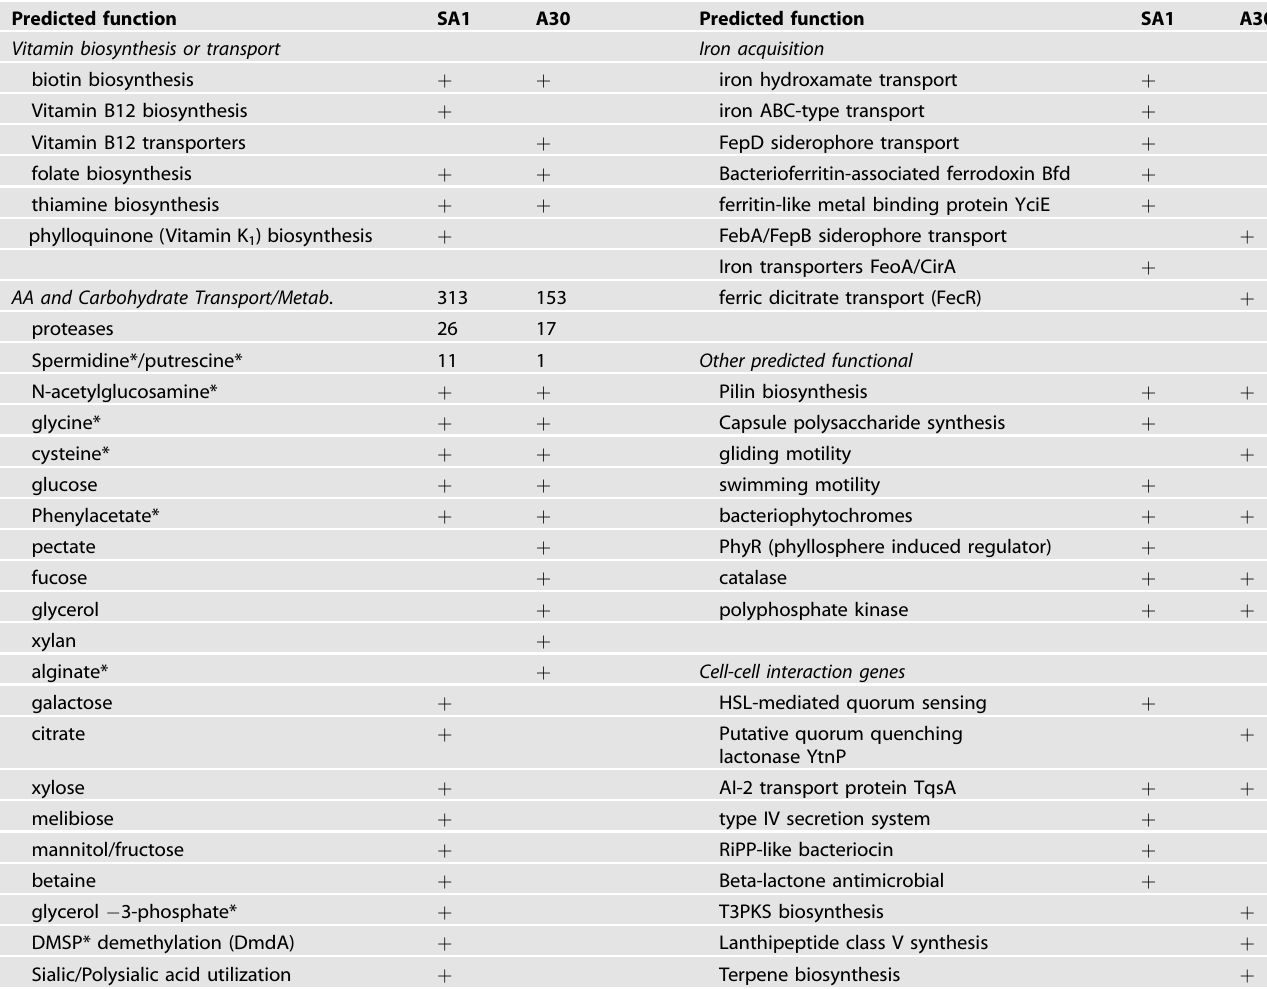
Table 2. Predicted functional genes for Sul fi tobacter sp . SA1 and Olleya sp . A30.